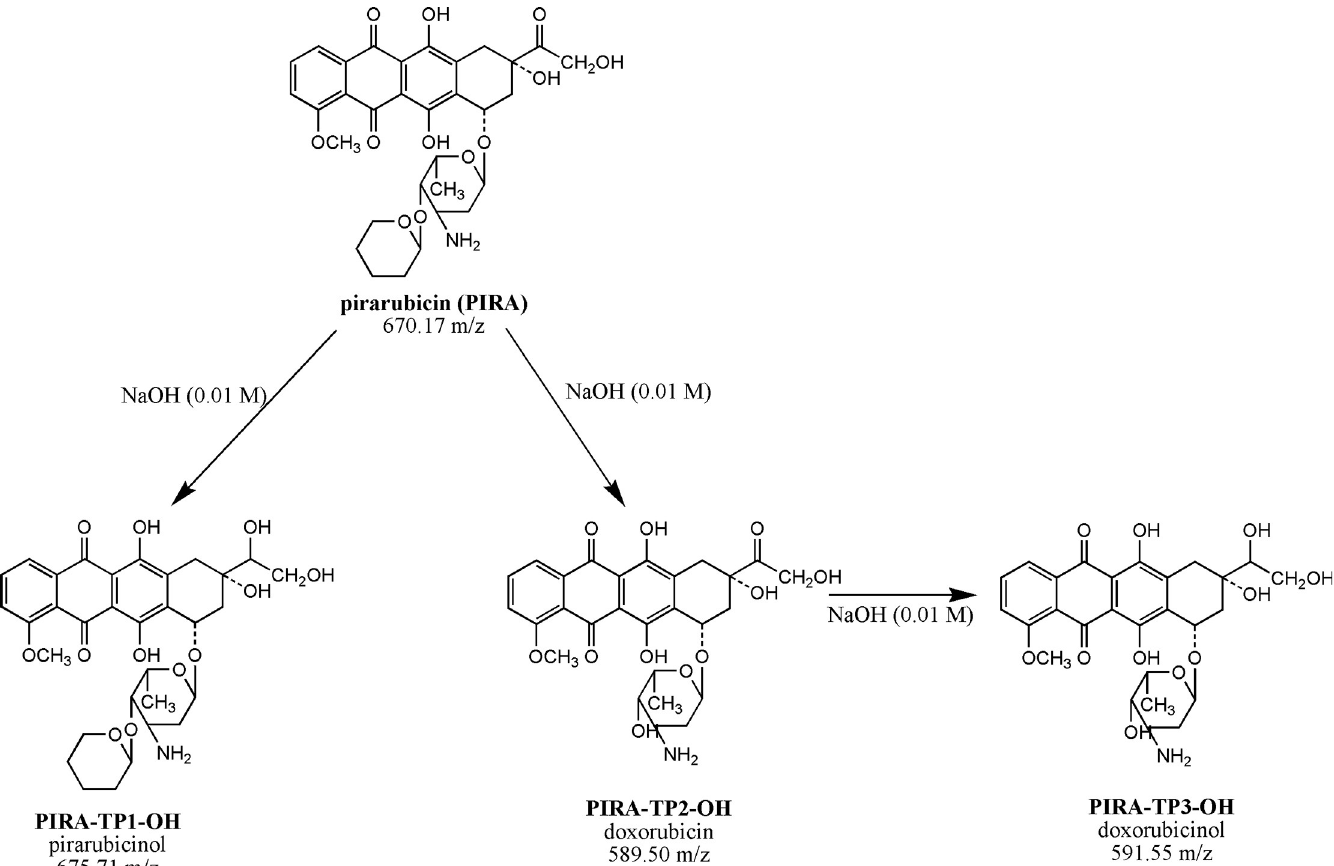
Fig 6. Scheme of PIRA degradation after its reaction with a solution of 0.01 M NaOH. Abbreviations: PIRA, pirarubicin; PIRA-TP1-OH, pirarubicinol, PIRA-TP2-OH doxorubicin, PIRA-TP3-OH, doxorubicinol.